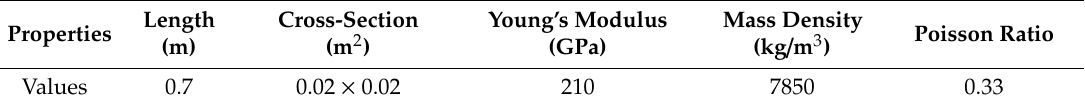
Figure 1. A cantilever beam with two open cracks. Table 1. Properties of cantilever